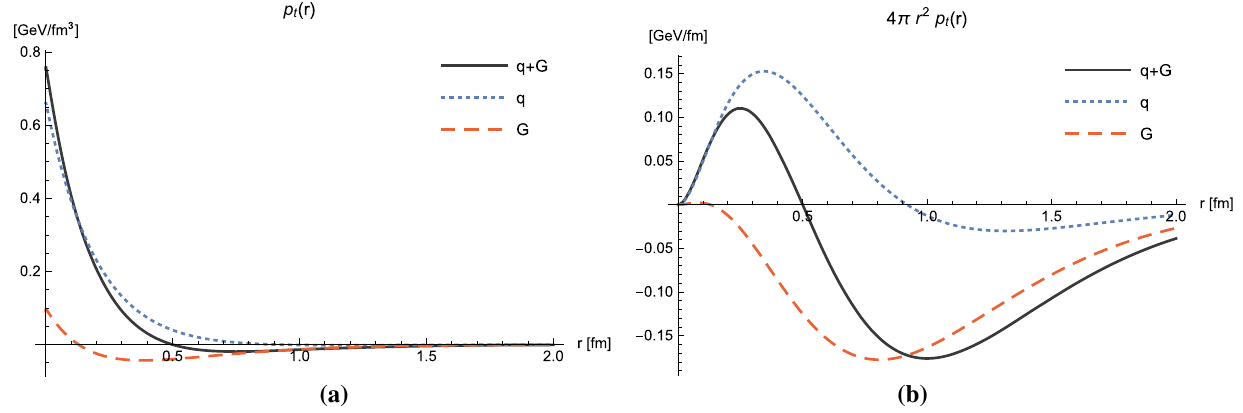
Fig. 5 Plots of the tangential pressure, a p t ( r ) and b 4 π r 2 p t ( r ) , using the multipole model (11) with parameters given in Table 1, see Eq. (36) or Eq. (41) for definitions in terms of GFFs